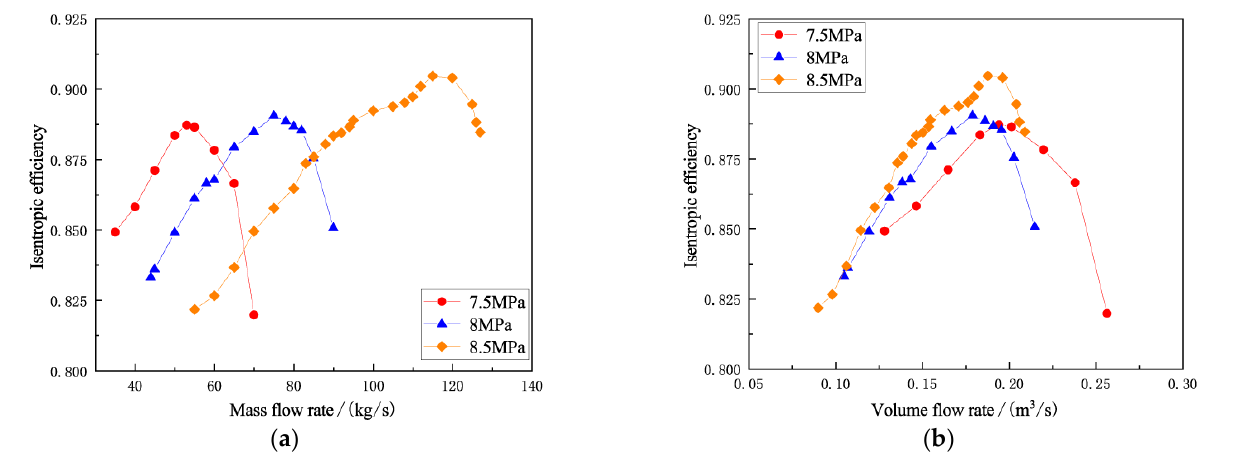
Figure 10. Performance curves at various inlet pressures. ( a ) Isentropic efficiency versus mass flow rate; ( b ) isentropic efficiency versus volumetric flow rate.